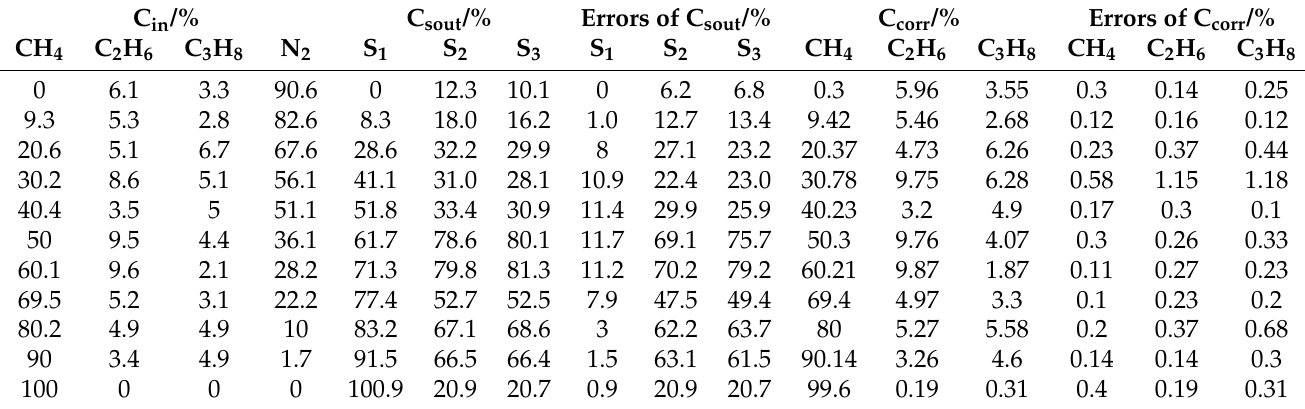
Table 4. Comparison of sensor output and the proposed monitoring system output.